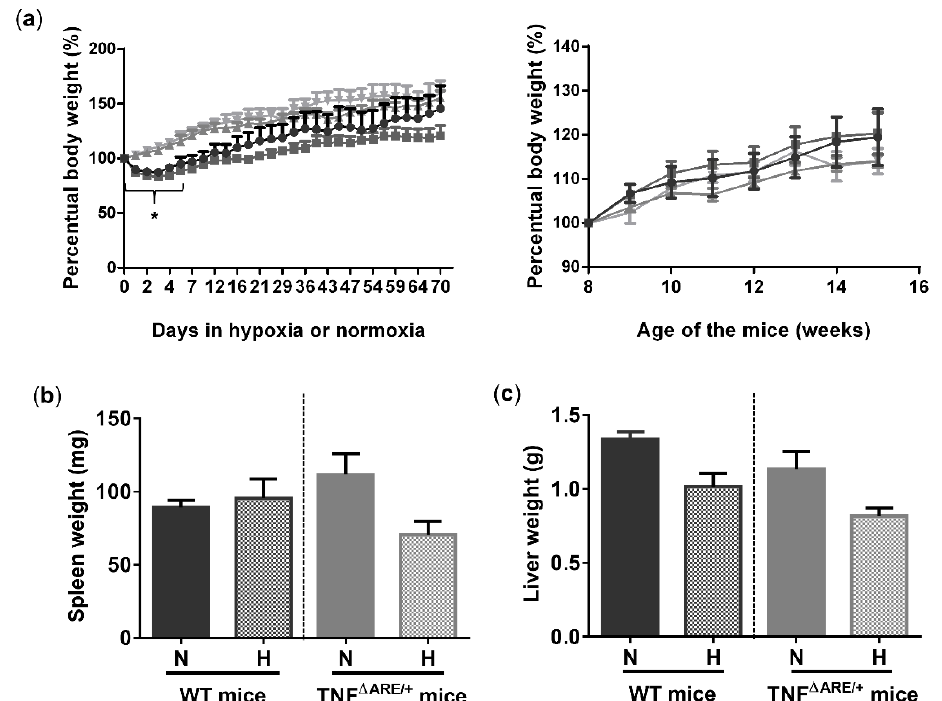
Figure 1. Environmental hypoxia does not influence the general well-being of WT mice and the clinical course of gut inflammation in TNF ∆ ARE/+ mice. ( a , left ) Percentual body weight evolution of TNF ∆ ARE/+ mice ( ) and their WT littermates ( ) housed for 10 weeks in hypoxia and TNF ∆ ARE/+ ( ) and WT mice ( ) housed for 10 weeks in normoxia, all from 5 until 15 weeks of age. ( a , right ) Percentual body weight evolution of 8 till 15-week-old TNF ∆ ARE/+ mice ( ) and their WT littermates ( ) housed for 10 weeks in hypoxia and TNF ∆ ARE/+ ( ) and WT mice ( ) housed for 10 weeks in normoxia, all from 5 until 15 weeks of age. ( b ) Spleen and ( c ) liver weight of all mice measured at week 15. Data are represented as the mean ± standard error of the mean (SEM). N: Normoxia; H: Hypoxia. * p <